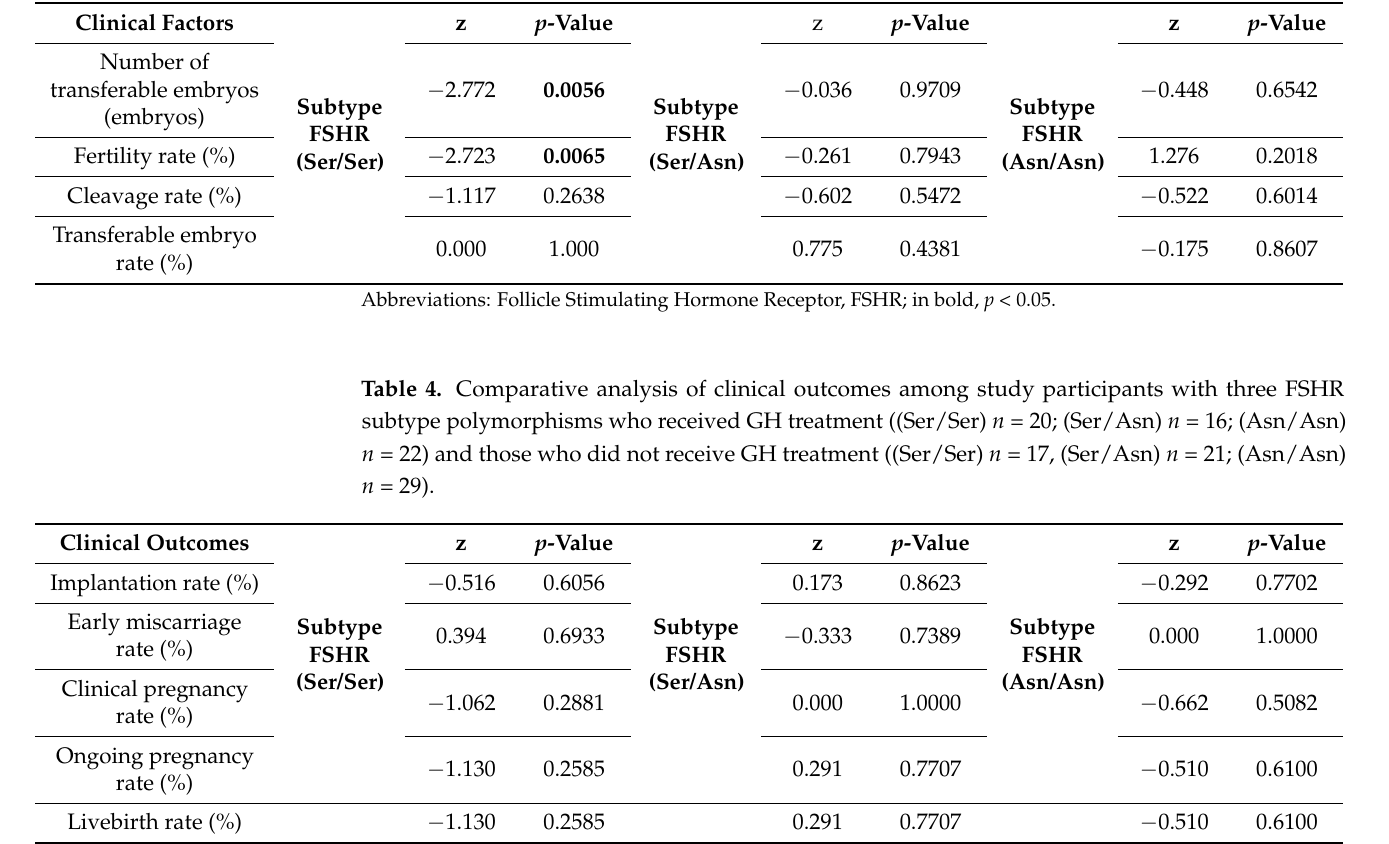
Table 3. Comparative analysis of clinical factors among study participants with three FSHR subtype polymorphisms who received GH treatment ((Ser/Ser) n = 20; (Ser/Asn) n = 16; (Asn/Asn) n = 22) and those who did not receive GH treatment ((Ser/Ser) n = 17, (Ser/Asn) n = 21; (Asn/Asn) n = 29).